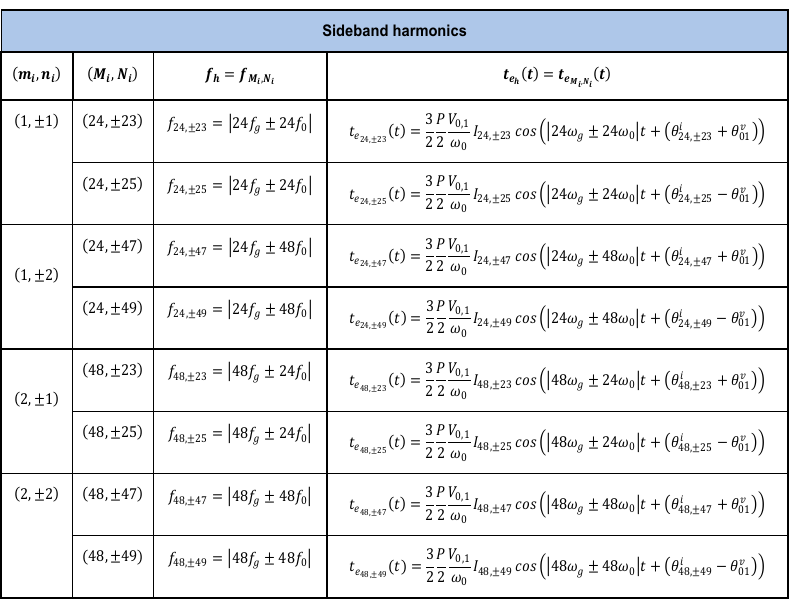
Figure 10. Harmonic families in a 24/24-pulse LCI system: sideband families.